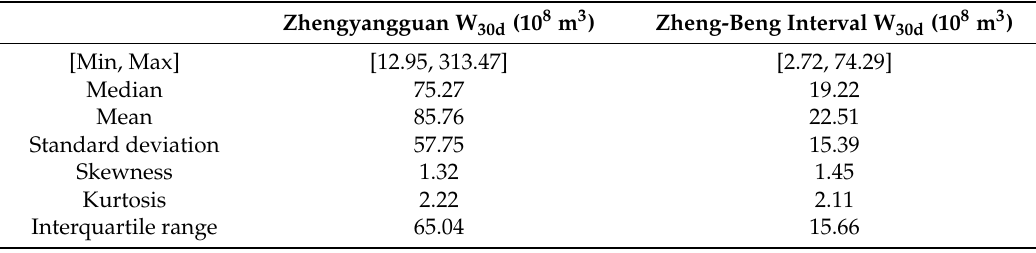
Figure 3. ( a ) Zhengyangguan W 30d and Zheng-Beng interval W 30d series. ( b ) Boxplot graph of Zhengyangguan W 30d and Zheng-Beng interval W 30d series. ( c ) Scatter plot of Zhengyangguan W 30d and Zheng-Beng interval W 30d together with linear regression line and histogram of marginal distributions on the side panels. Table 2. Statistics of Zhengyangguan and Zheng-Beng interval W 30d.